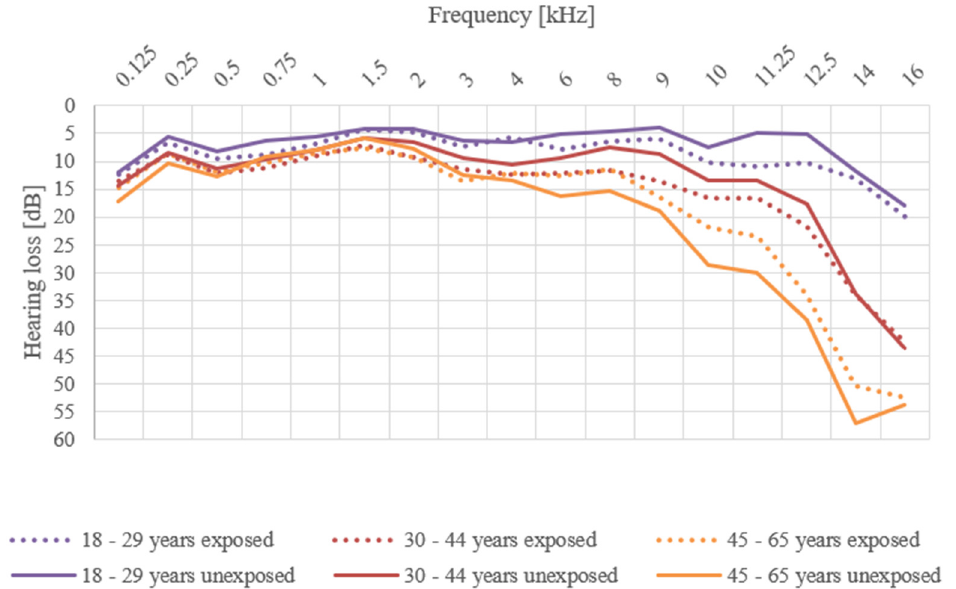
Figure 1. Average hearing loss of women exposed or unexposed to workplace noise.